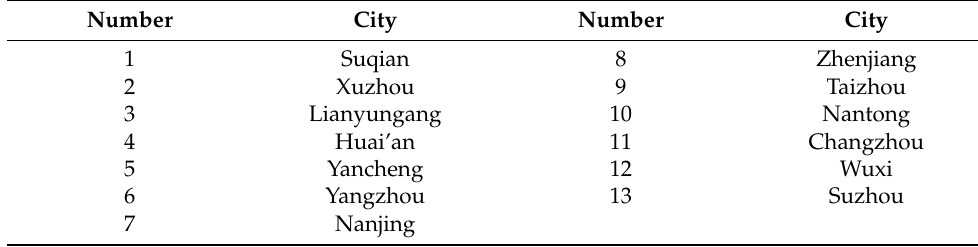
Table 3. Serial number of the